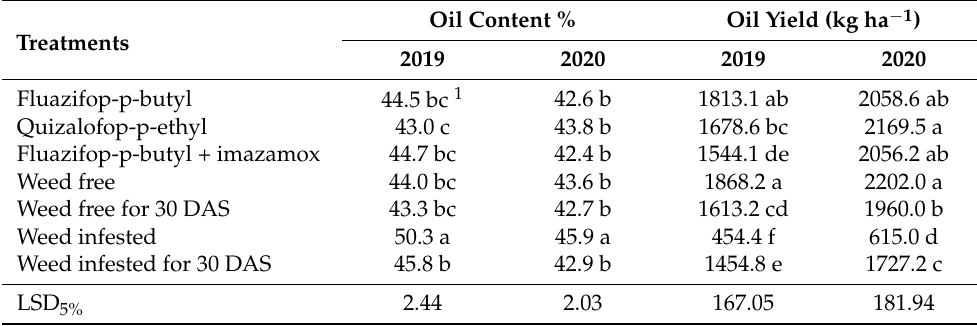
Table 2. Effects of various control treatments of Johnsongrass on oil content (%) and yield (kg ha − 1 ) of sunflower at different days after sowing (DAS), in 2019 and 2020.